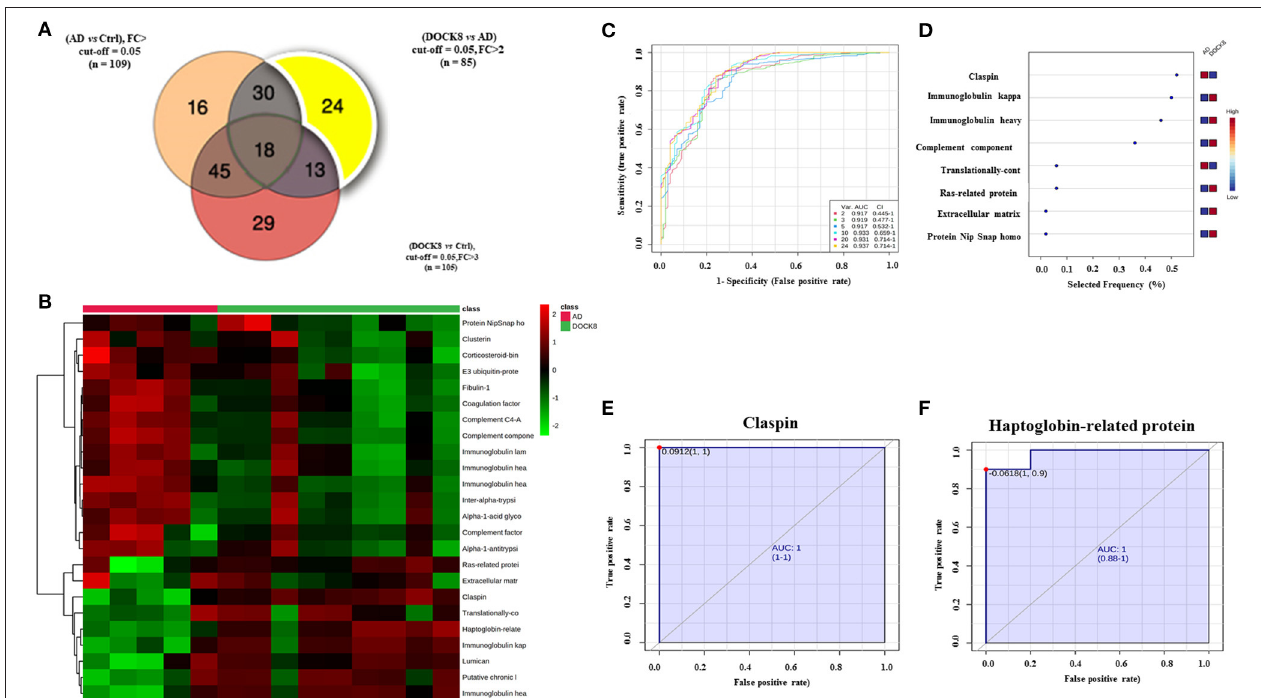
FIGURE 3 | Biomarker evaluation between patients with DOCK8 deficiency and patients with AD based on the proteomics profile. (A) A Venn diagram showing 24 proteins differentially uniquely between DOCK8 deficient vs. AD (fold change cut-off; 2, and ANOVA (FDR p < 0.05). (B) Heat map was created by average reading of the entities hierarchical clustering for the 24 proteins, where the similarity was based on Pearson, which shows significantly differentially regulated proteins specific between DOCK8 and AD groups. (C) An exploratory receiver-operating characteristics (ROC) curve generated by the PLS-DA model shows the area under the curve [AUC = 0.937 (0.445-1)] for the top two proteins. (D) Frequency plot of differentially expressed proteins between the two groups. (E) The ROC curve of Claspin [AUC-1 (1-1)] and (F) Haptoglobin-related protein is downregulated in patients with DOCK8 compared to patients with AD [AUC-1 (0.88-1)]. Data were normalized, transformed, and scaled by median, log, and Pareto scaling to ensure all the data were under Gaussian distribution. A combination of ANOVA and fold change analyses is represented for paired analysis, where the x-axis (FDR corrected p -value) and the y-axis are true positives. DOCK8, dedicator of cytokines 8; AD, atopic